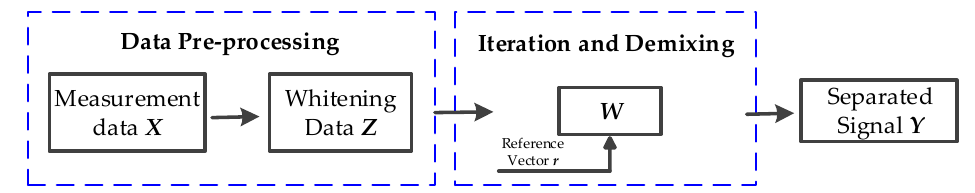
Figure 4. Principle diagram of the constrained independent component analysis algorithm.